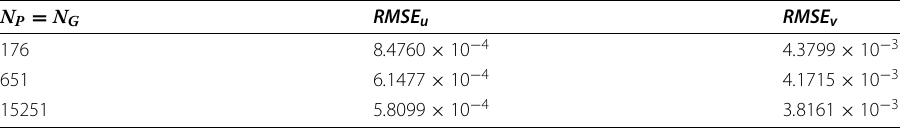
Table 1 The RMES for Case 2 by making N P = N G